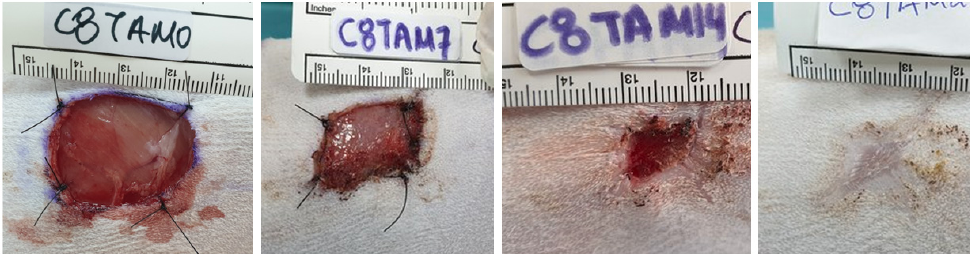
Figure 2. PRP wounds during different measurement times (days 0, 7, 14, 25).